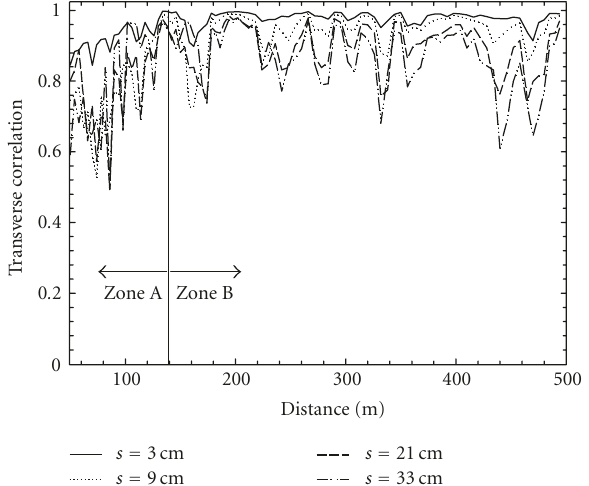
Figure 10: Average correlation in zone B , versus frequency, and for four antenna